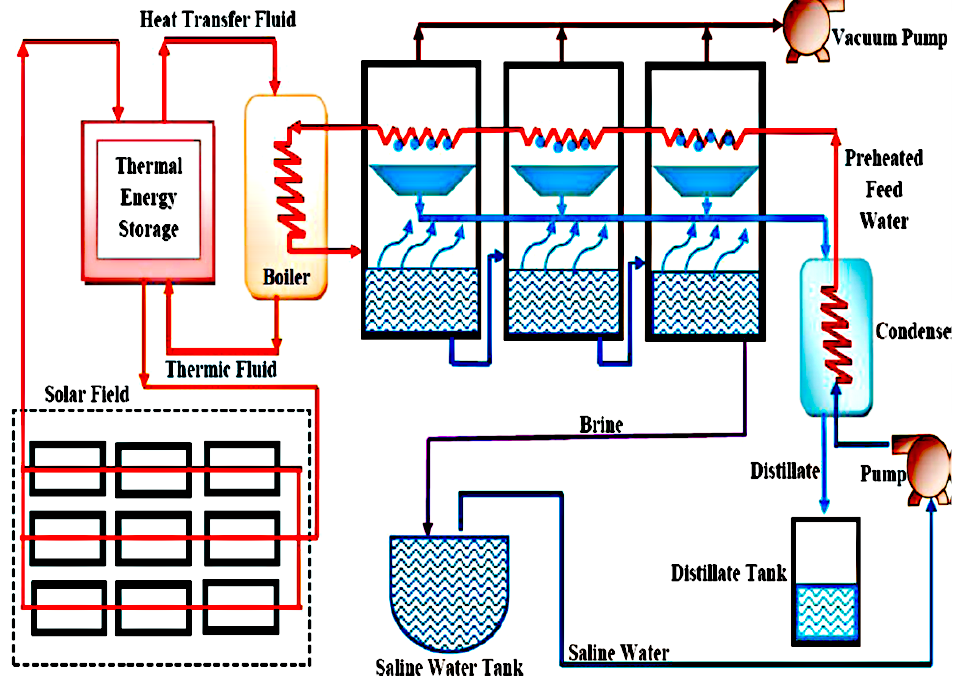
Figure 8. Solar powered multi-stage flash distillation [58].